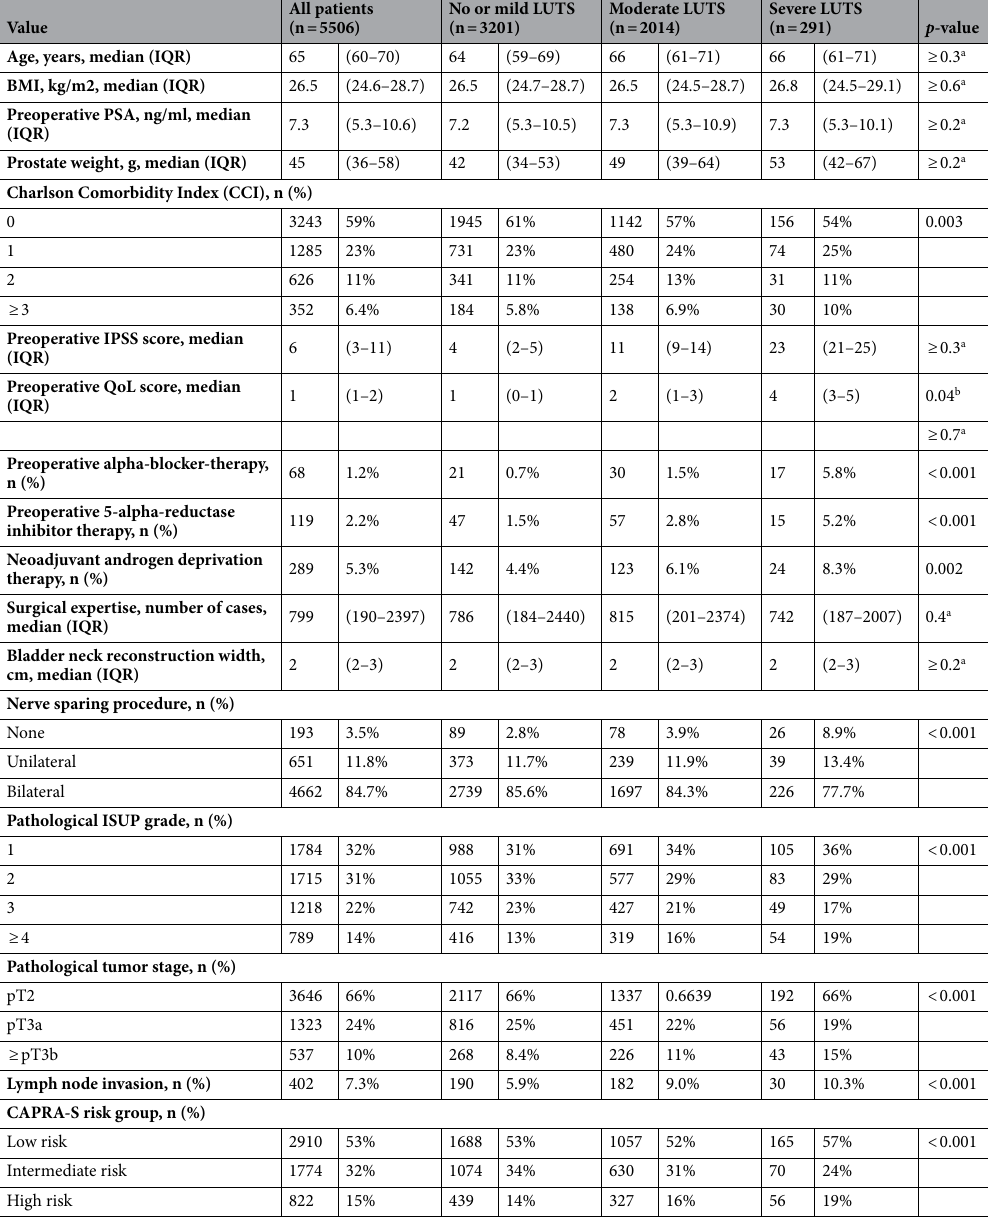
Table 1. Baseline characteristics of 5506 prostate cancer patients treated with robot-assisted radical prostatectomy at the Prostate Cancer Center Northwest, Gronau, Germany between 2006 and 2018 stratified according to the preoperative LUTS. CAPRA-S: the Postsurgical Cancer of the Prostate Risk Assessment Score; IPSS: International Prostate Symptom Score; ISUP: International Society of Urological Pathology; LUTS: lower urinary tract symptoms; QoL: quality of life. a Denotes insignificant p-values for each comparison between the LUTS severity categories, none or mild vs. moderate LUTS, none or mild vs. severe LUTS and moderate vs. severe LUTS. b Comparison no or mild vs. moderate